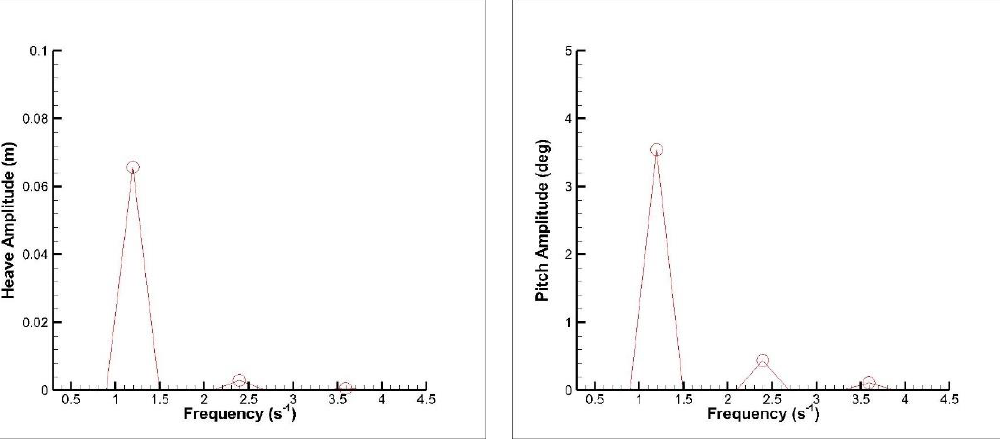
Figure 18. Time histories of heave ( left ) and pitch ( right ) motions for C7, Fn B = 2.26, mono hull.